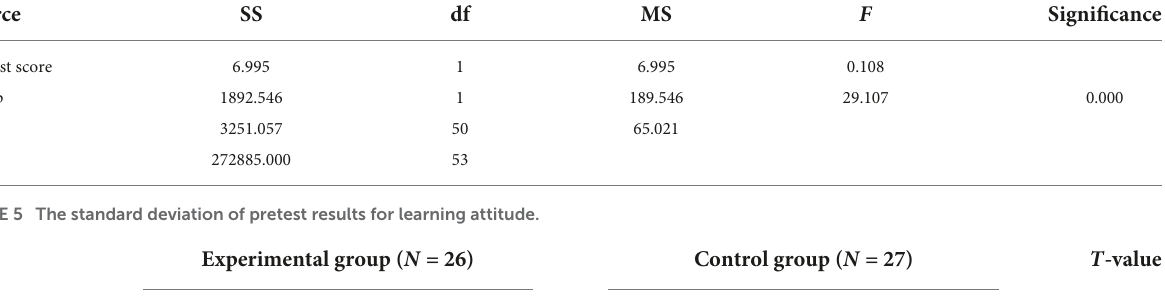
TABLE 4 The significant results of ANCOVA analysis of pre-test and post-test results of learning effectiveness.